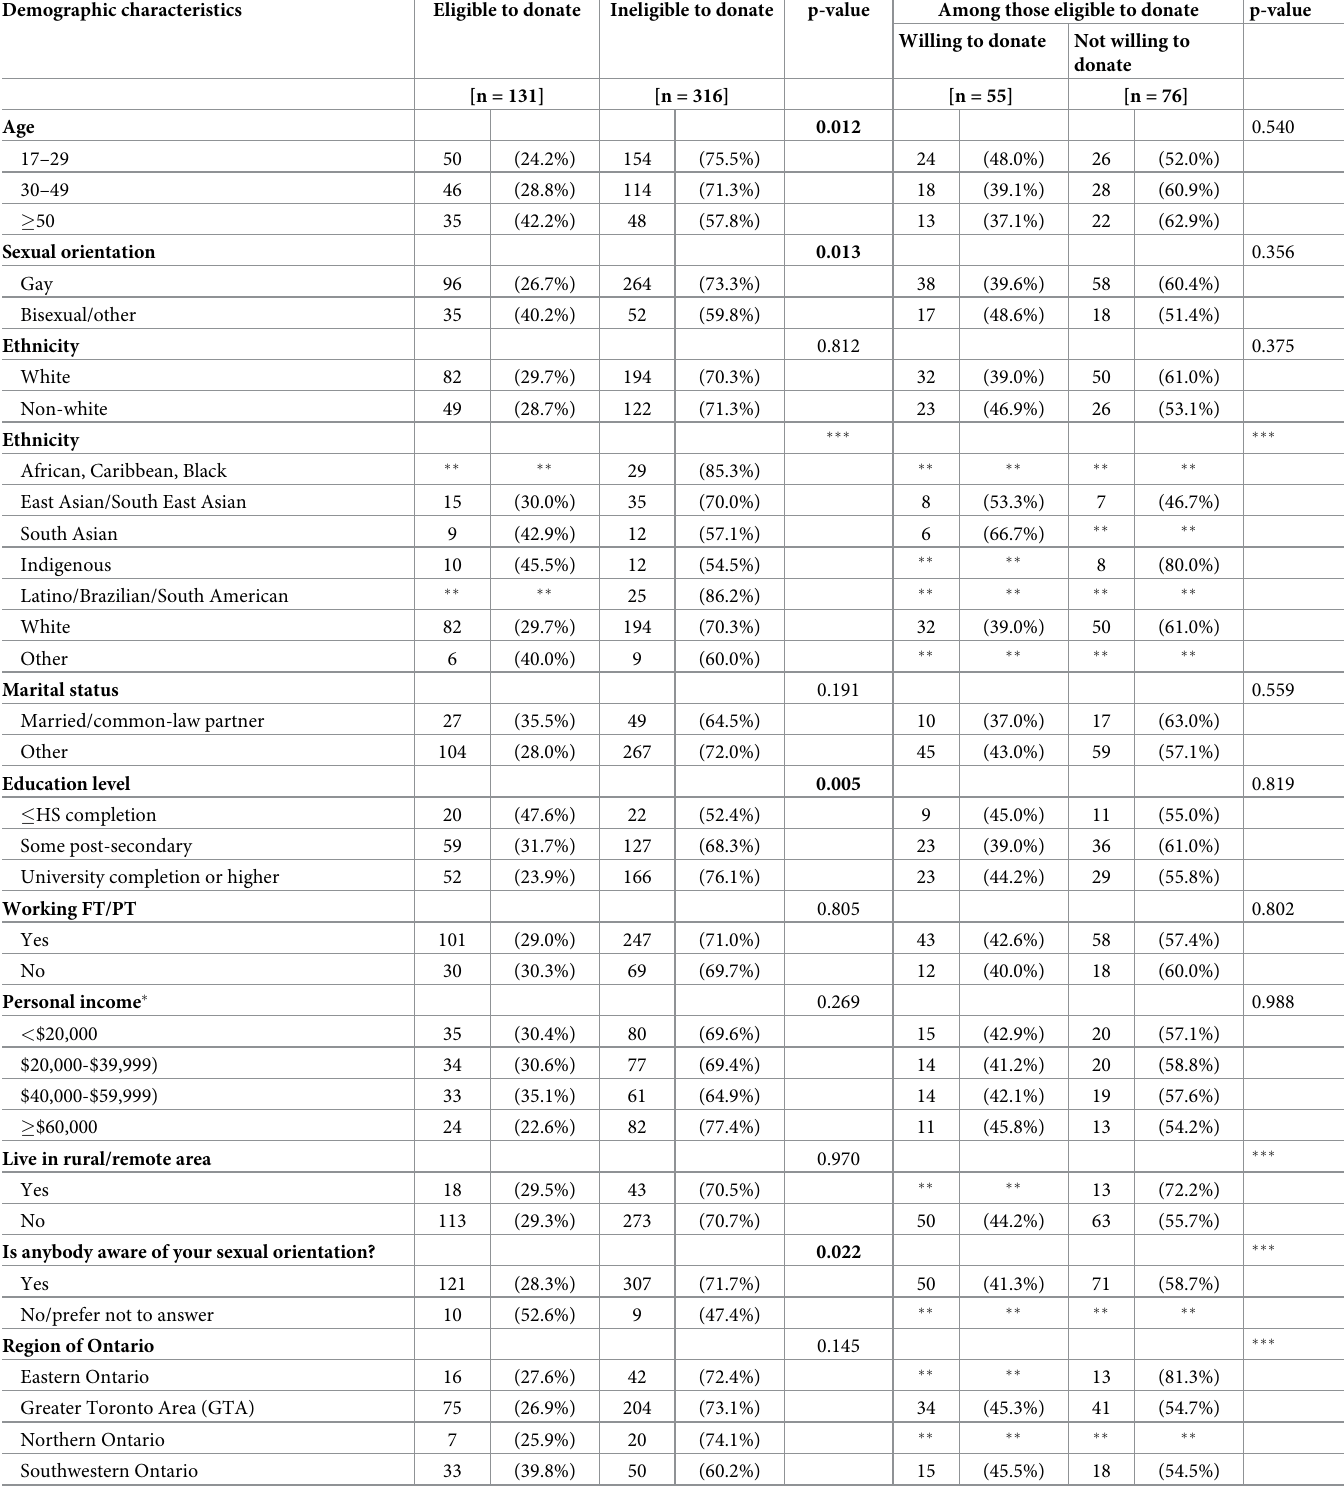
Table 3. Characteristics of participants by eligibility and willingness to donate blood under the 3-month deferral policy. Demographic